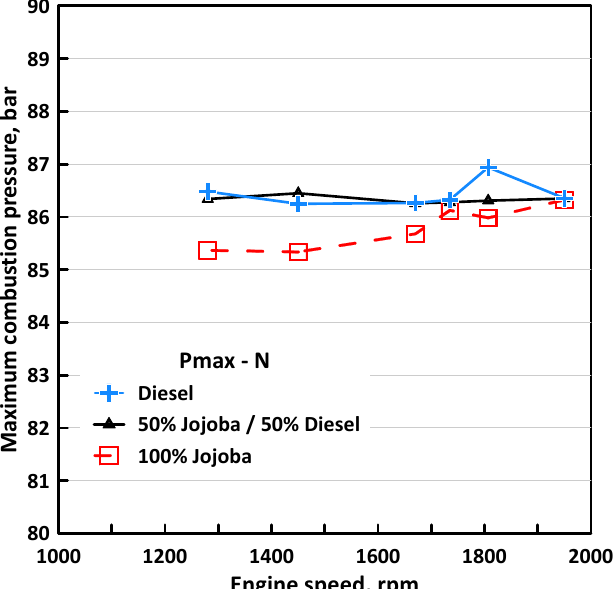
Figure 11. Effect of engine speed on the maximum combustion pressure for three fuels used.